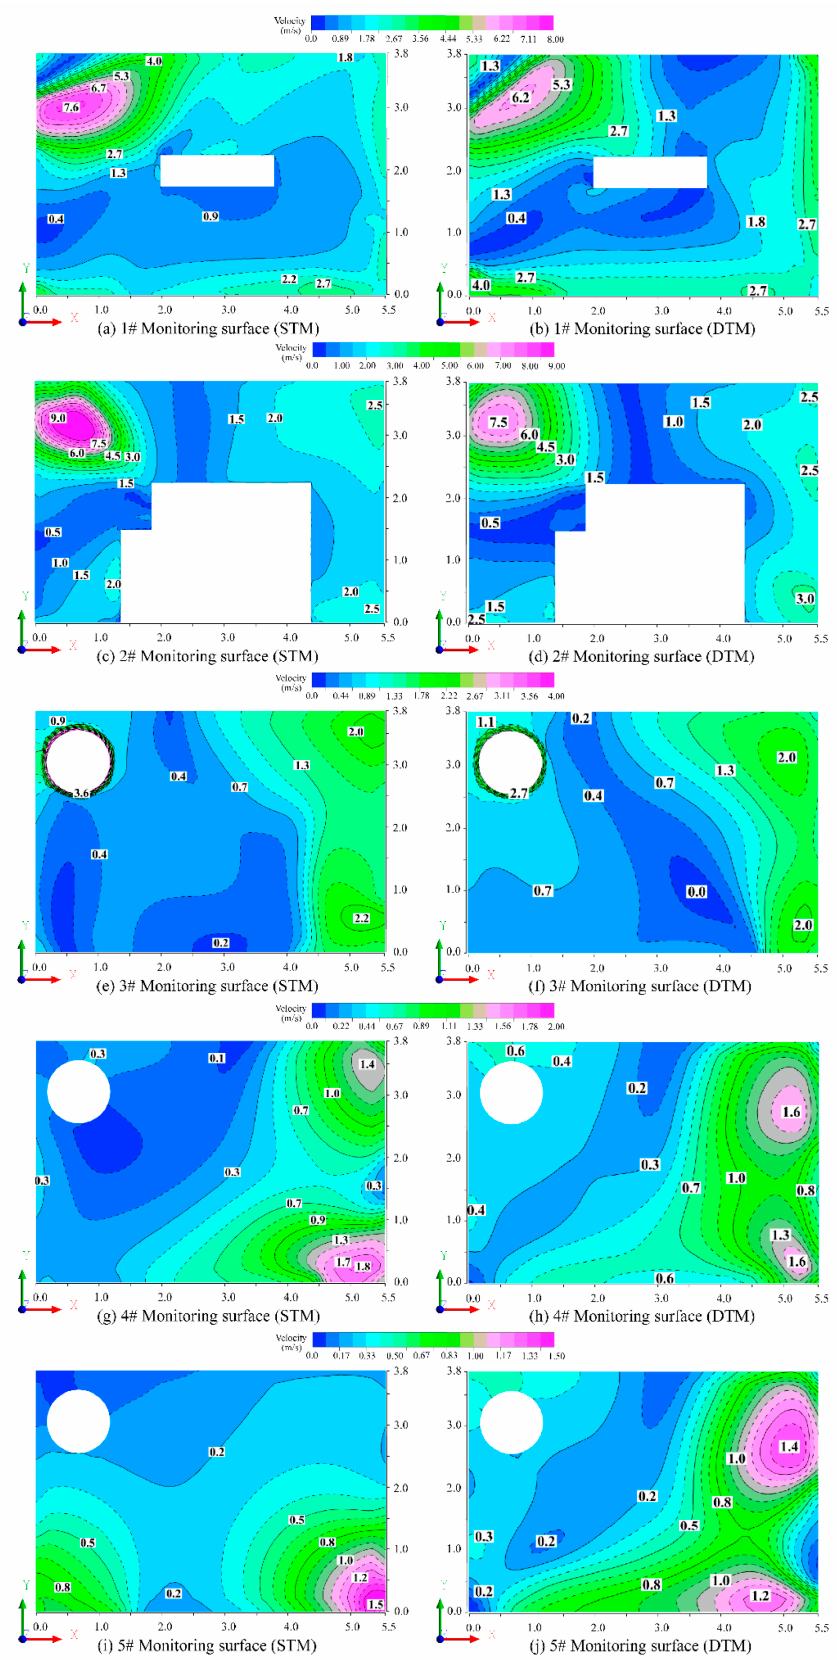
Figure 11. The speed cloud map at 1#~5# monitoring surface under the dynamic and stationary condition.